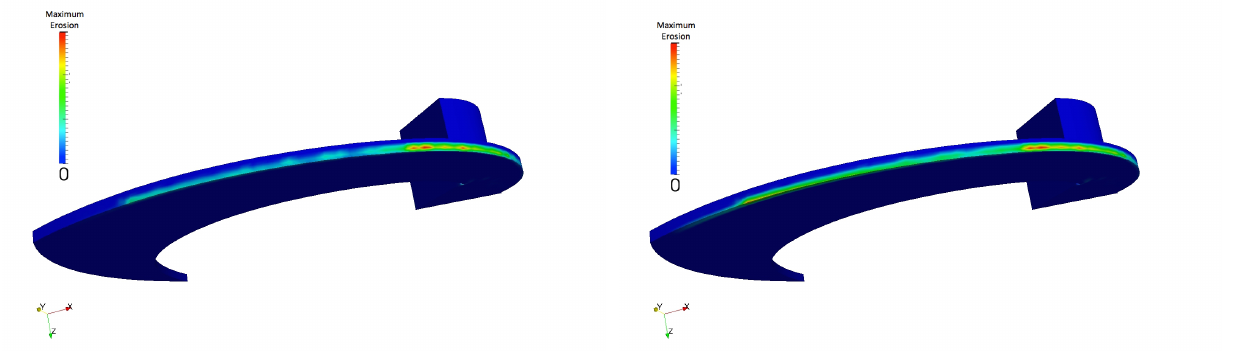
Figure 4: Finnie’s model calculated erosion.